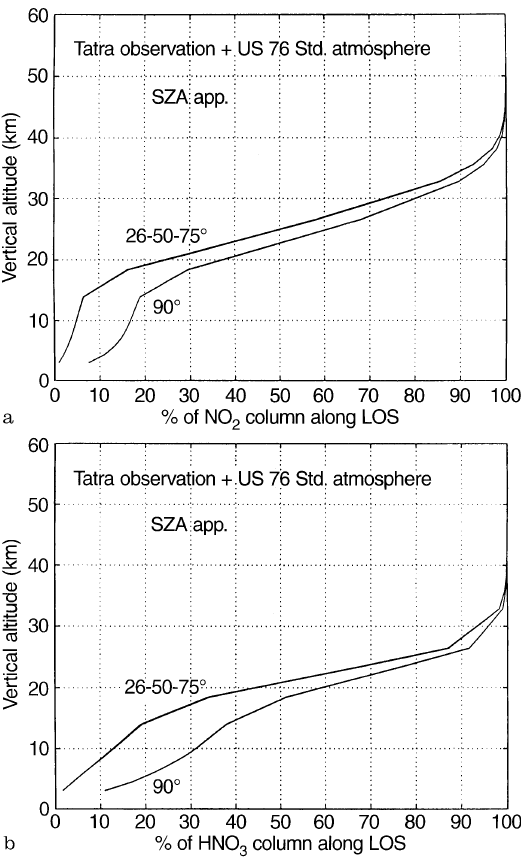
Fig. 3a, b. Growth of the accumulated molecular amount along the line-of-sight (LOS) versus altitude above earth’s surface, for a ground-based observation from the Tatra Observatory at different apparent solar zenith angles (SZA app) of a NO (cid:50) , b HNO (cid:51)